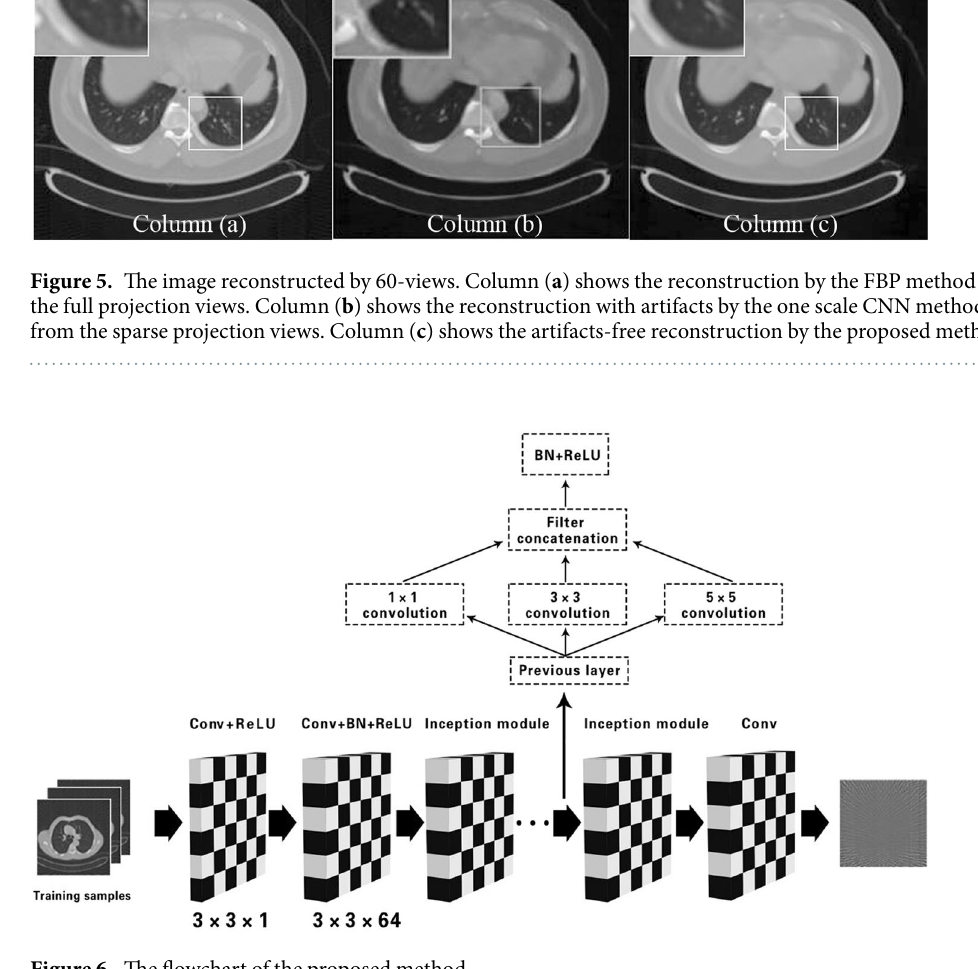
Figure 6. The flowchart of the proposed